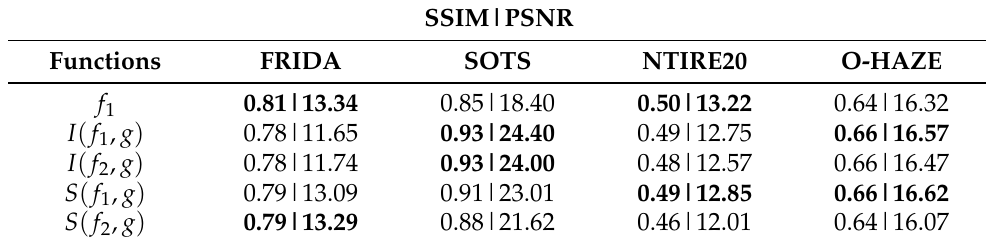
Table 1. Comparison of the SSIM and PSNR indexes on the four datasets with the five interpolation functions listed in the text before the table. I is for Interpolation, S for Switch. The two best results are in